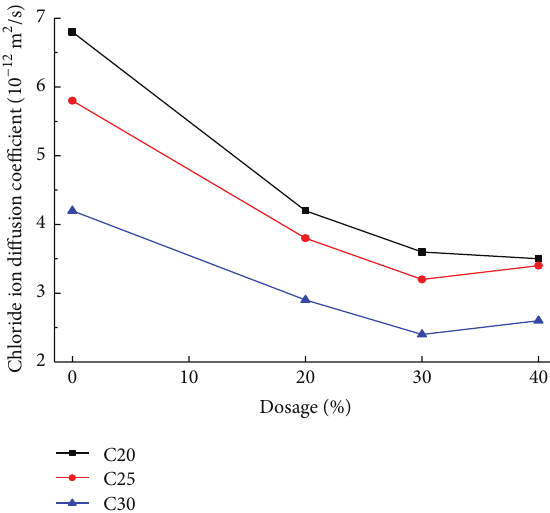
Figure 7: The results of antipermeability